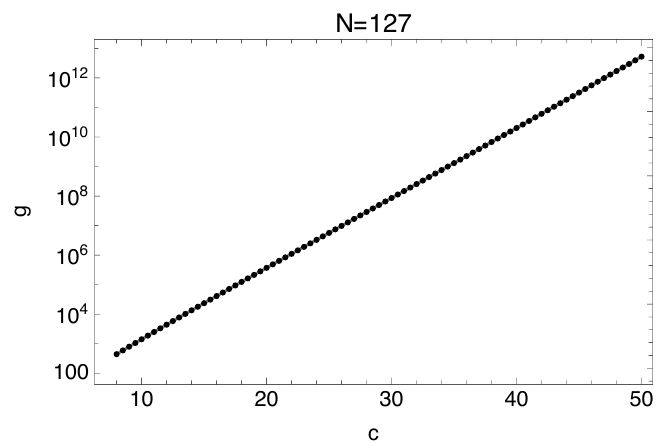
Figure 15. Upper bounds on the g -function associated with end-of-the-world branes in pure gravity, with h gap ≥ c . The lower bounds on g with ∆ gap ≥ c 24 lower